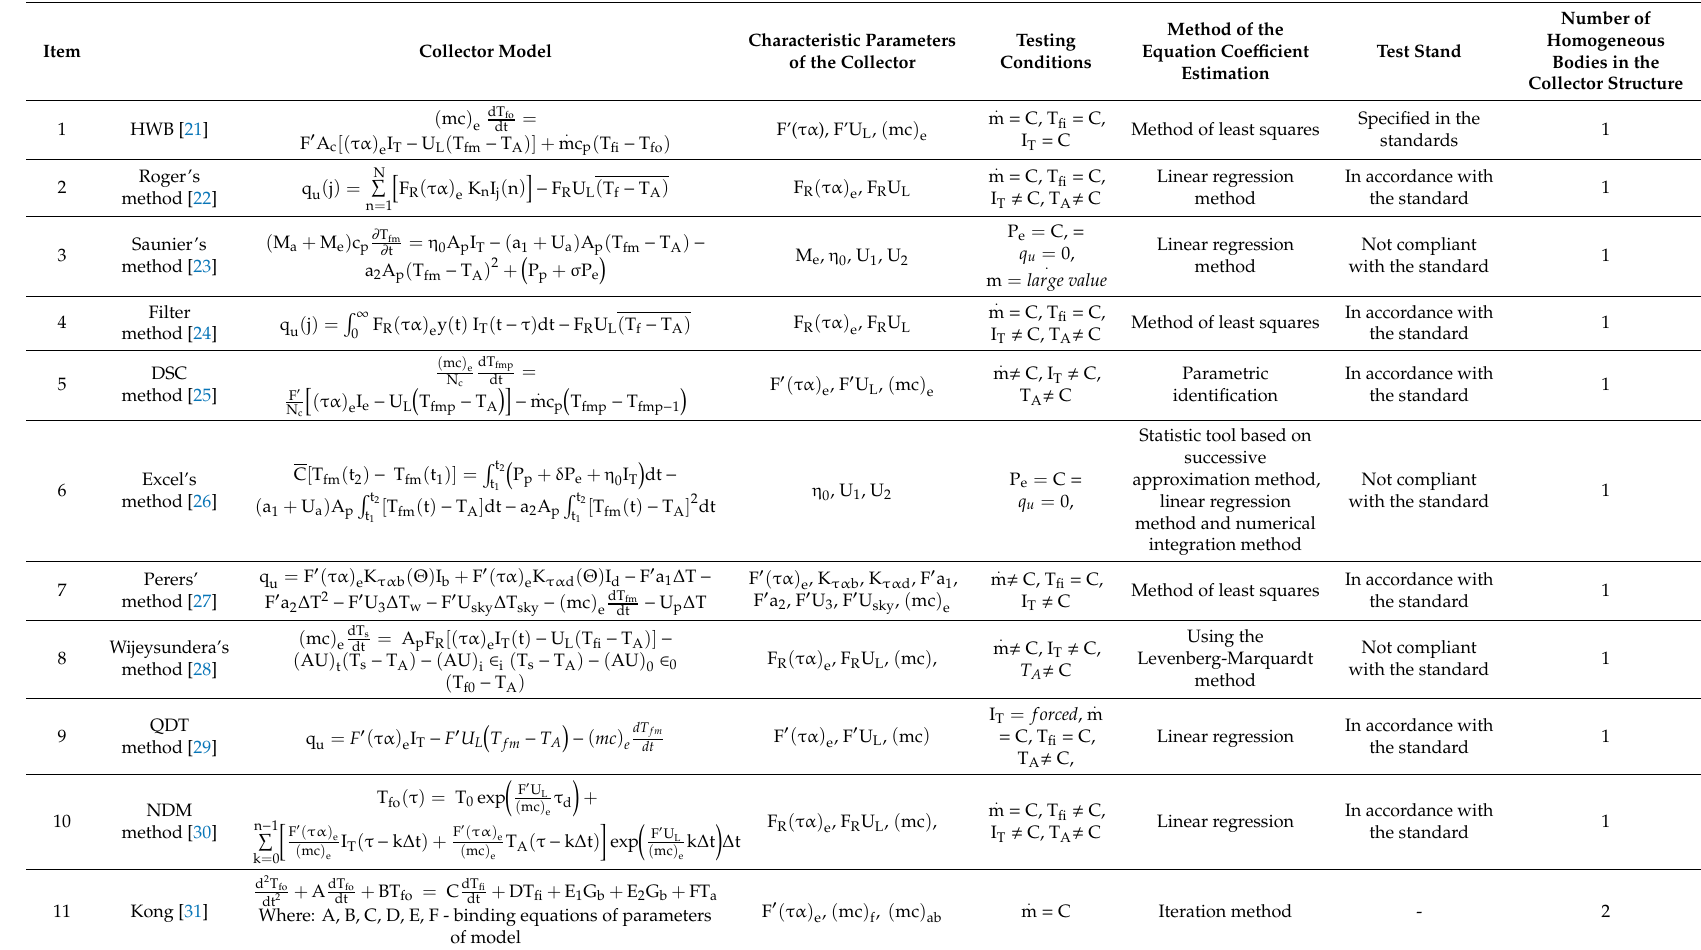
Table 1. Characteristic parameters for each method and conditions for which it is